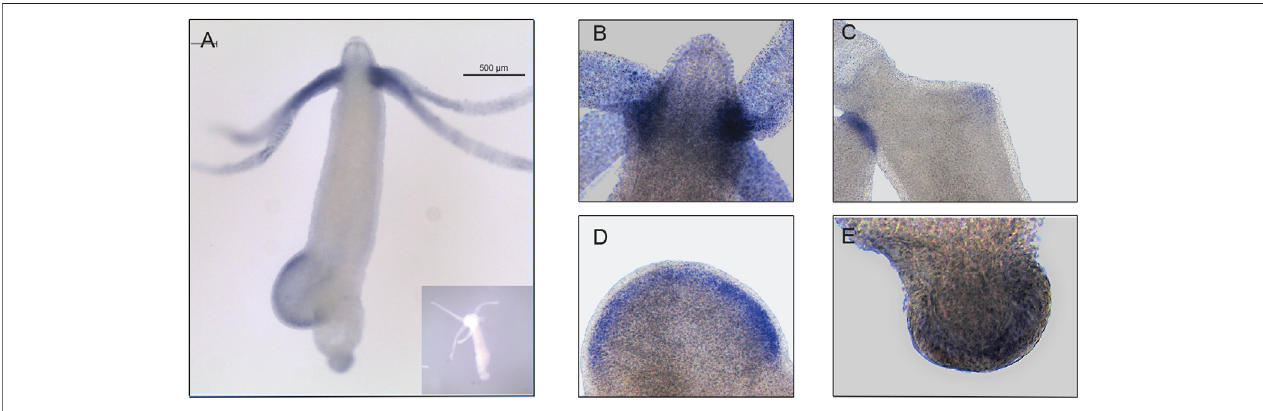
FIGURE 3 | Hvul_yap expression analysis in Hydra . Whole-mount in situ hybridization of Hvul_yap expression at (A) Region across the polyp (inset shows polyp probed with a sense RNA probe). (B) Head, (C) early bud/late bud foot, (D). mid-stage bud, (E) basal disk (The scale bar is 500 µm long, N (cid:2)